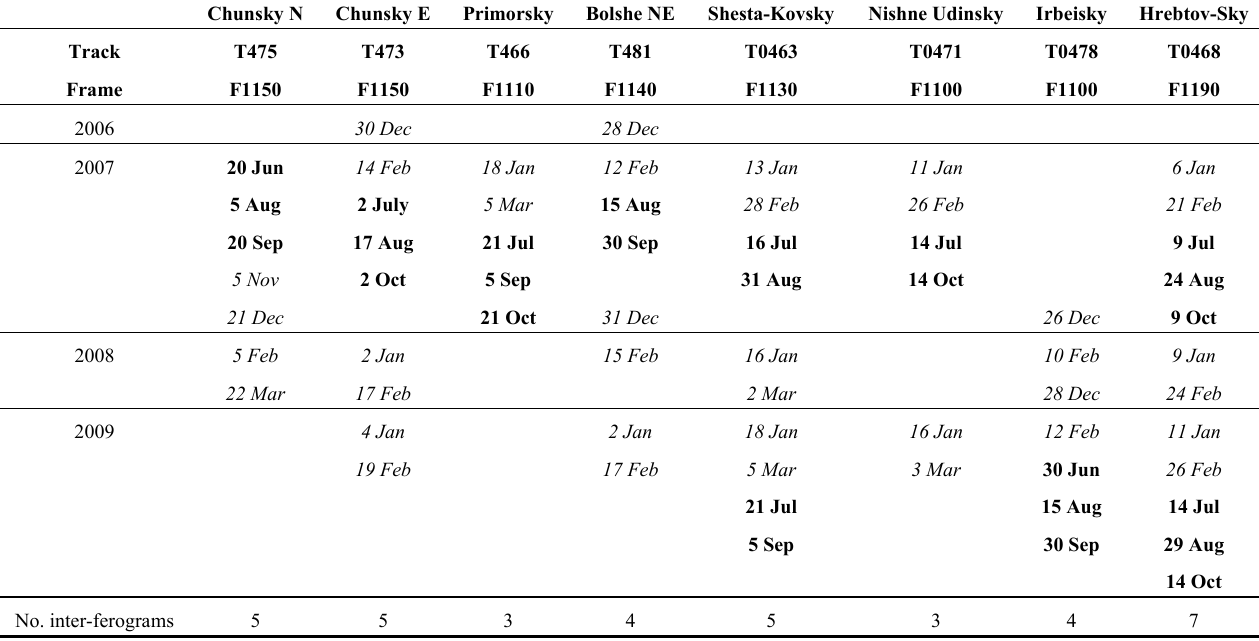
Table 2. Employed Phased Array type L-band SAR (PALSAR) data. Italics: fine beam single polarization (FBS) (frozen conditions) ; Bold: fine beam dual polarization (FBD) (unfrozen conditions) . Only image pairs from consecutive cycles were employed for interferogram processing, resulting in a total of 36